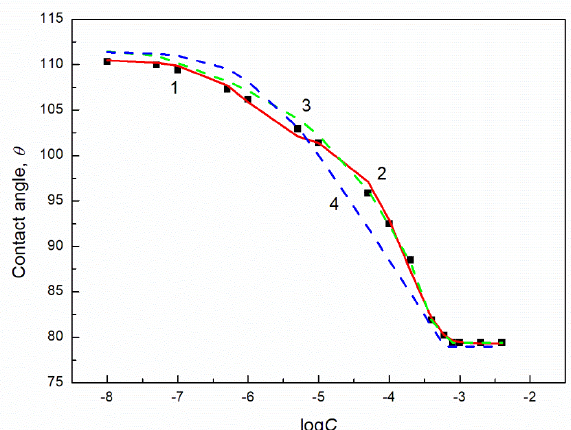
Figure 4. A plot of the contact angle ( θ ) of aqueous solution of TX165 + RL on PTFE at the constant RL concentration equal to 0.00625 vs. the logarithm of TX165 concentration ( C ). Points 1 correspond to the measured values, curves 2 correspond the values calculated form the exponential function of the second order: